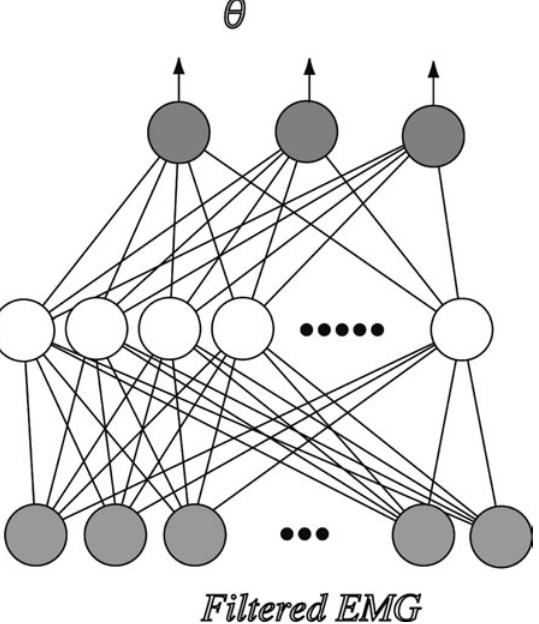
Figure 2 Three-layer neural network